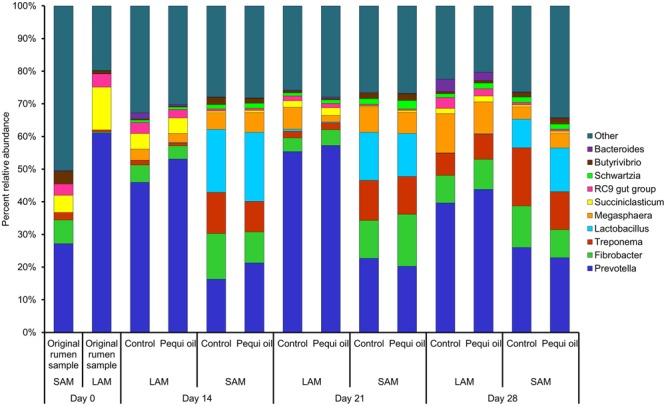
Classification of 16S rRNA gene sequences at the genus level for each individual sampling day, incubation temperature, sample type and treatment. Only the ten most relatively abundant genera are displayed (N = 3 for all samples). LAM = liquid-associated microbes, SAM = solid-associated microbes.